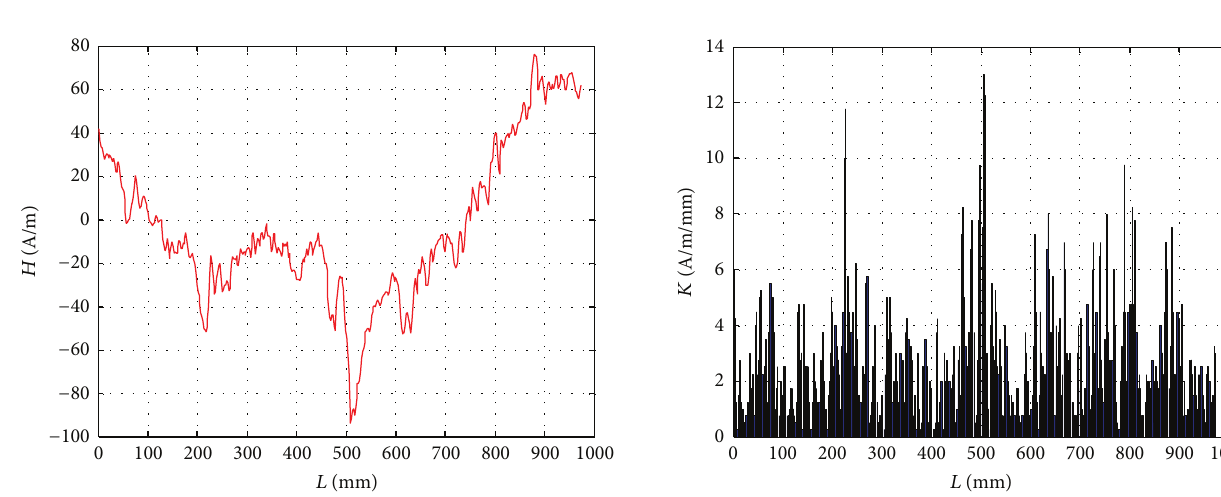
Figure 6: Gradient value variation of MMM